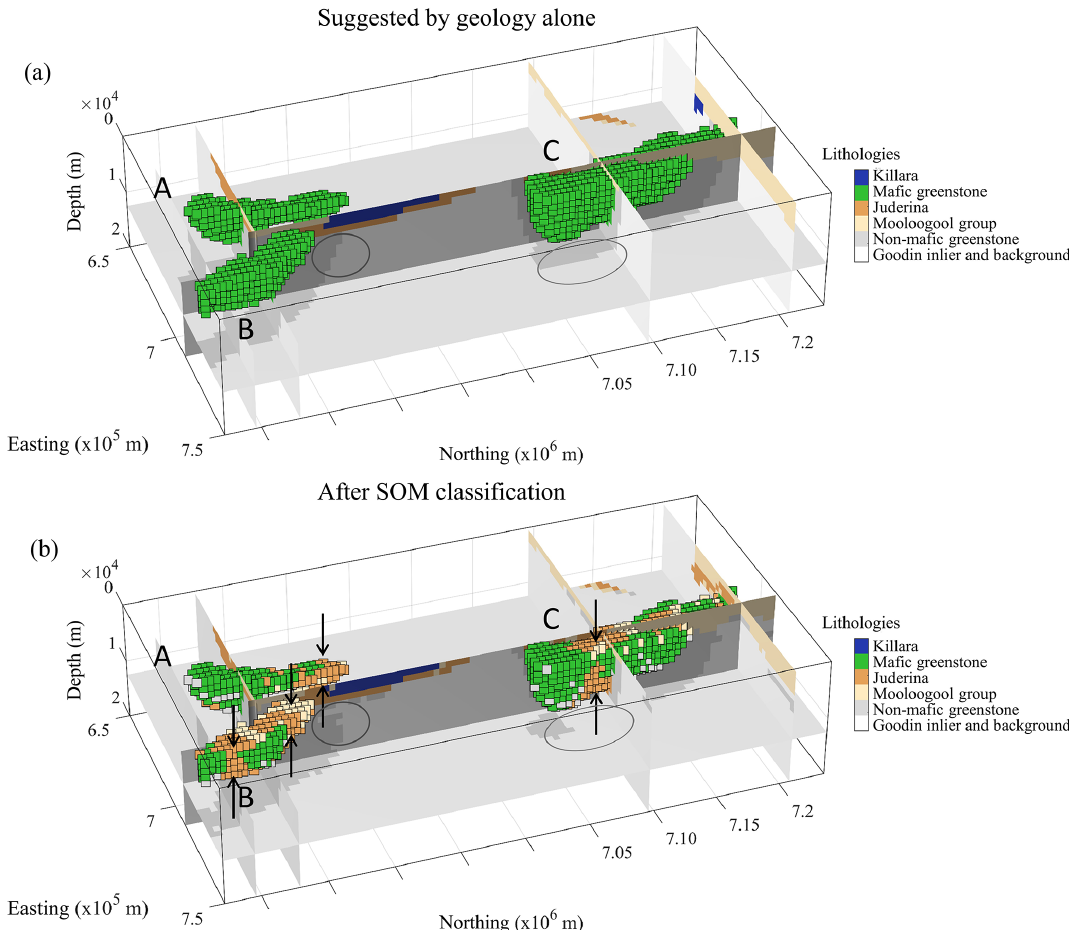
Figure 11. Mafic greenstone belts and their surroundings following geological modelling only (a) and after SOM classification (b) . The cells shows in panels (a) and (b) have the same geographical location and are coloured according to lithology. The vertical arrows show areas where mafic greenstone is thinner than suggested by geology only. The elliptical shapes shows zones where expected non-mafic greenstone is replaced by the background